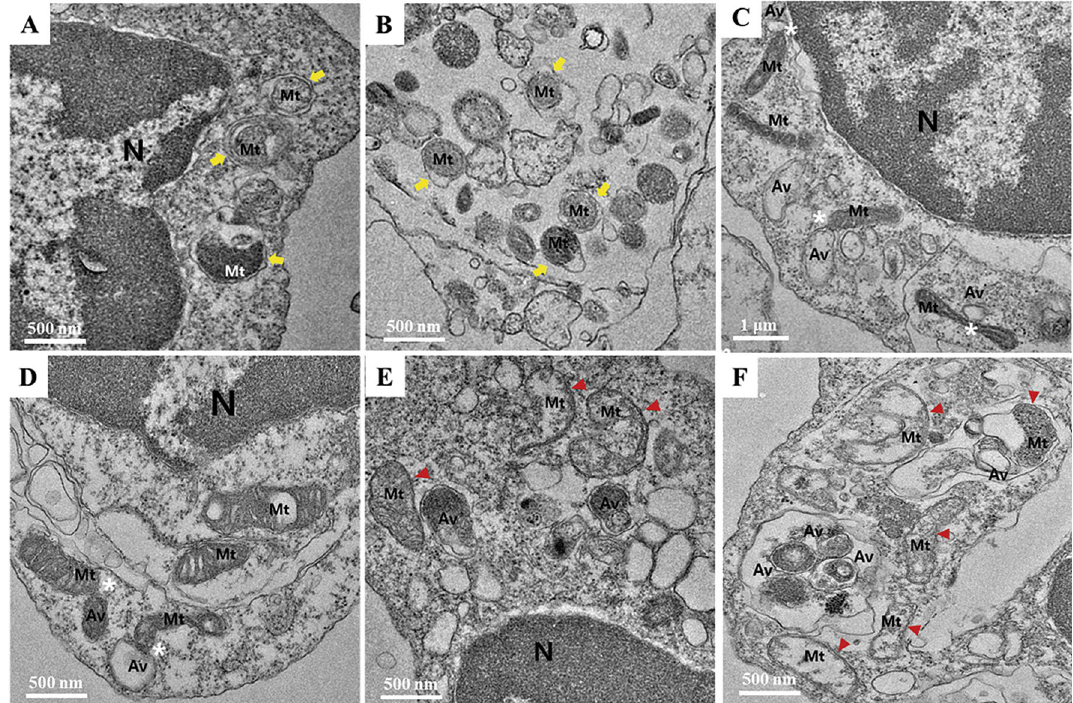
Figure 1. Transmission electron microscopy images of mitochondria with abnormal morphology with autophagy and mitophagy in CSF cells from SAH patients with DCI. ( A , B ) Autophagic vacuoles containing damaged mitochondria are indicated with yellow arrows. ( C , D ) Interaction between mitochondria and autophagic vacuoles is indicated by white asterisks. ( E , F ) Autophagic vacuoles were observed close to damaged mitochondria (red arrowhead) with matrix swelling and collapsed cristae. Mt mitochondria, Av autophagic vacuoles, N nuclear. Scale bar; 1 μm, 500